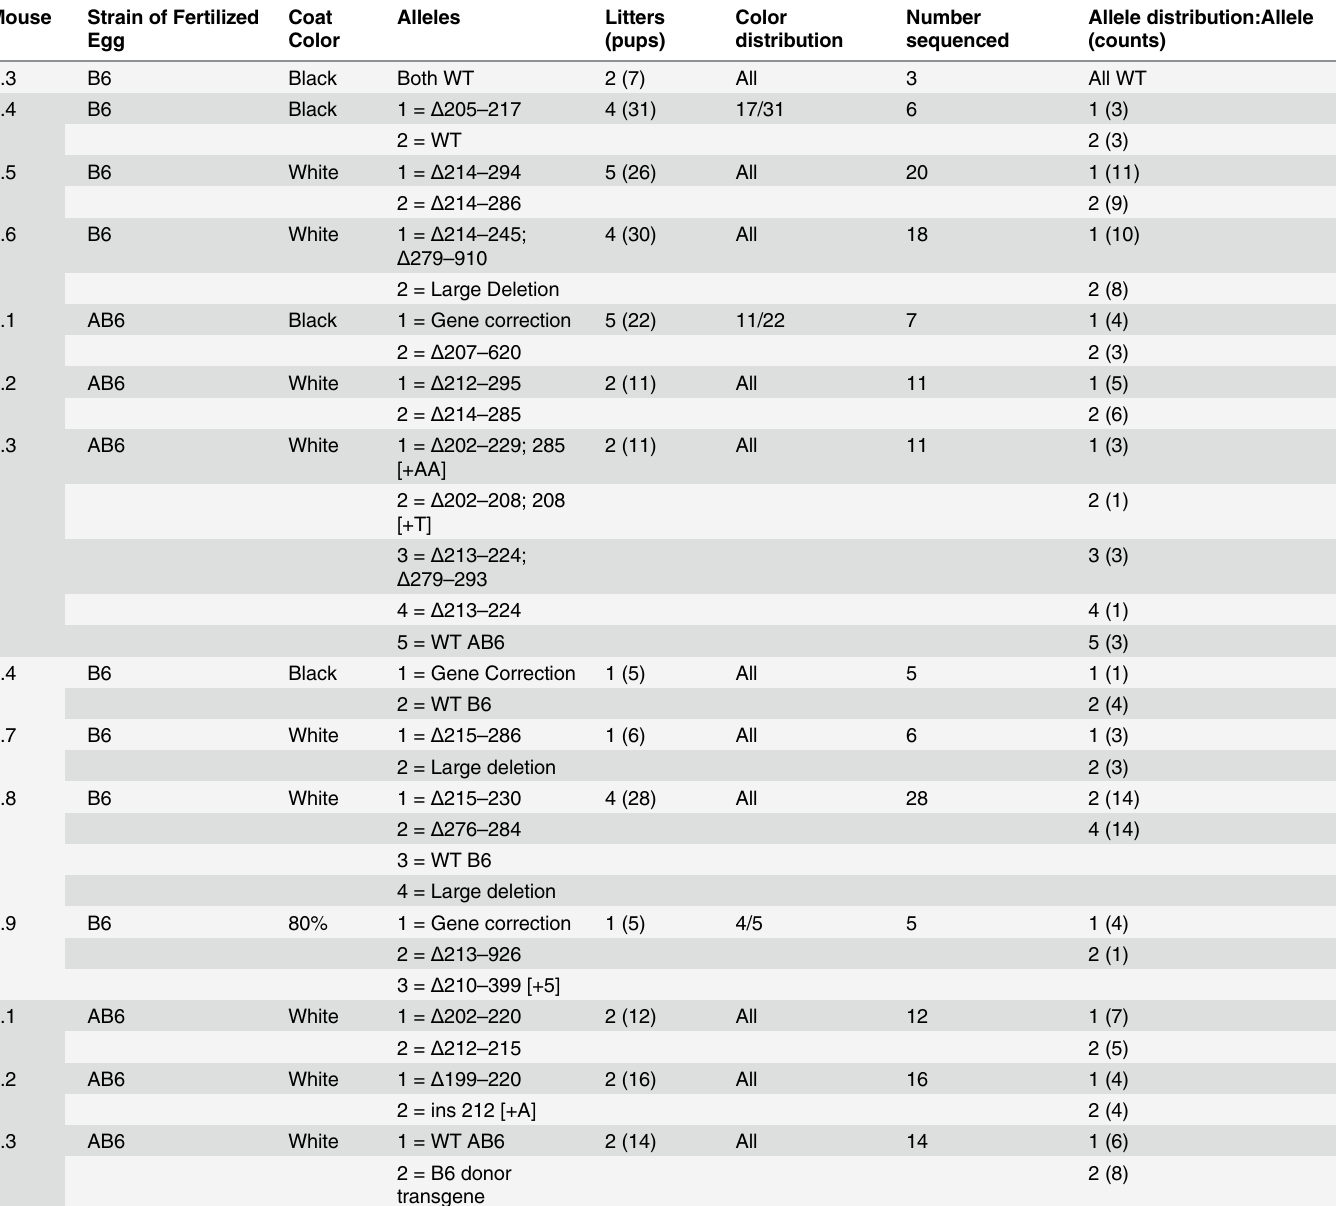
Table 3. Transmission and distribution of mutant alleles in F1 offspring. Mouse